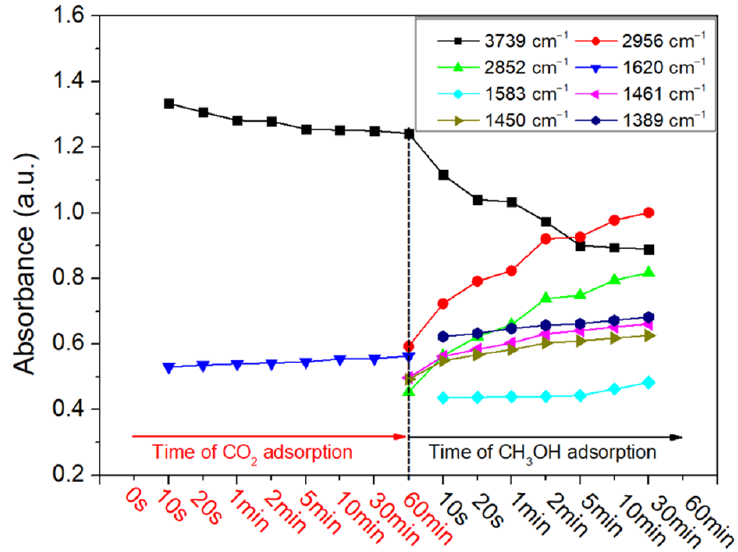
Figure 6. Infrared peak intensities of the different functional groups for Zr/SBA-15 taken during the experiments shown in Supplementary Figures S4 and S5. Peaks intensities are normalized from 3739 to 1389 cm − 1 .